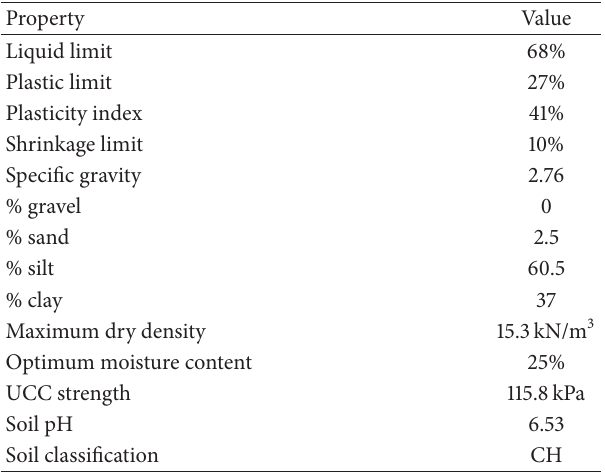
Table 1: Properties of